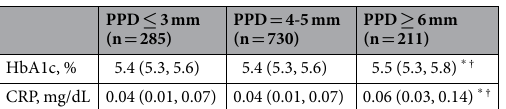
Table 4. Comparisons of HbA1c and CRP in different periodontal condition. Continuous variables are expressed as median (first quartile, third quartile) deviation. * p < 0.01, compared with the participants with PPD ≤ 3 mm, using the Kruskal Wallis test with post hoc Mann Whitney U test (corrected Bonferroni’s method). † p < 0.05,compared with the participants with PPD = 4–5 mm, using the Kruskal Wallis test with